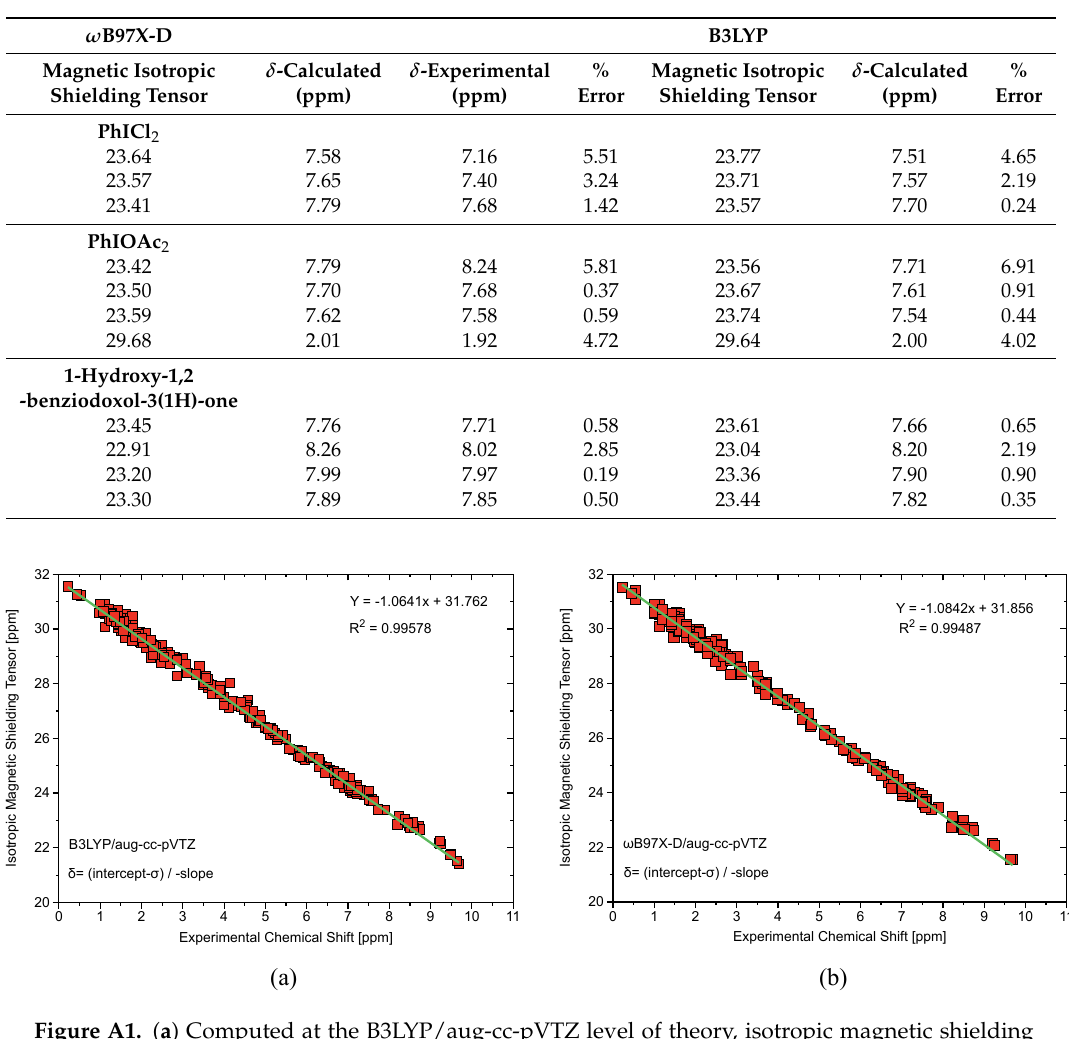
Figure A1. ( a ) Computed at the B3LYP/aug-cc-pVTZ level of theory, isotropic magnetic shielding tensors plotted against experimental NMR chemical shifts showing strong linear correlation and a slope close to − 1 which is indicative of minimization of systematic error. ( b ) Computed at the ω B97X-D/aug-cc-pVTZ level of theory, isotropic magnetic shielding tensors plotted against experimental NMR chemical shifts again showing strong linear correlation and slope close to −